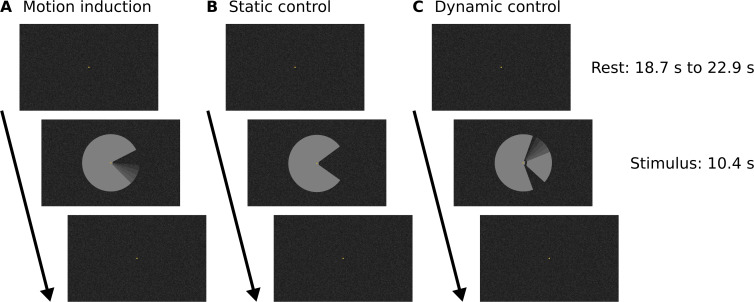
Experimental design.Stimuli were presented in a block design with rest blocks of variable duration. The three stimulus conditions were presented in separate runs (A, B, C). A central fixation dot and the random texture background pattern were present throughout the duration of each run. See Figure 1—figure supplement 1 for a higher-resolution image of the ‘Pac-Man’ stimulus and the texture background.